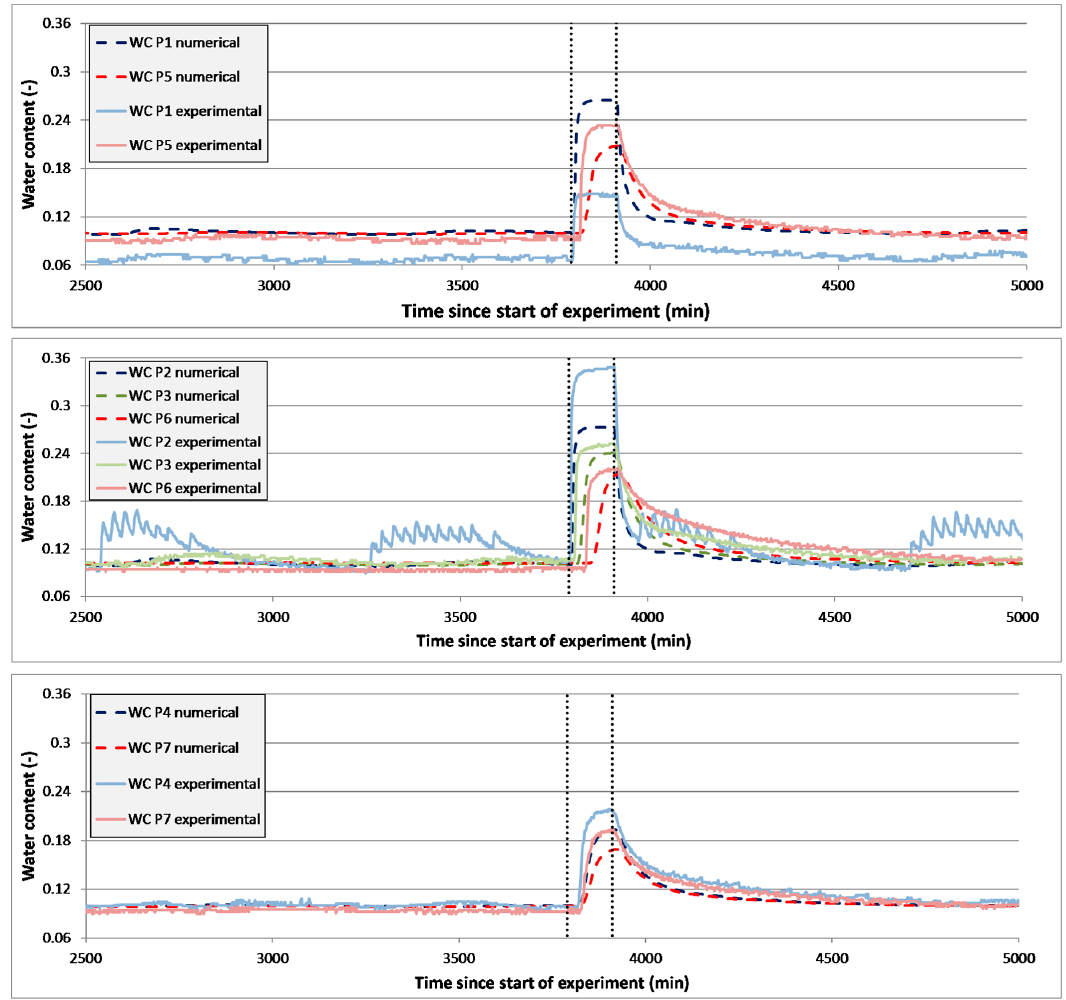
Figure 4. Results for simulation of water contents for scenario WW-RE-Ref (jnt.) as compared to observed values in the laboratory tank experiment for the time 2500 to 5000 min. after onset of the numerical experiment, black dotted line indicates duration of precipitation event.